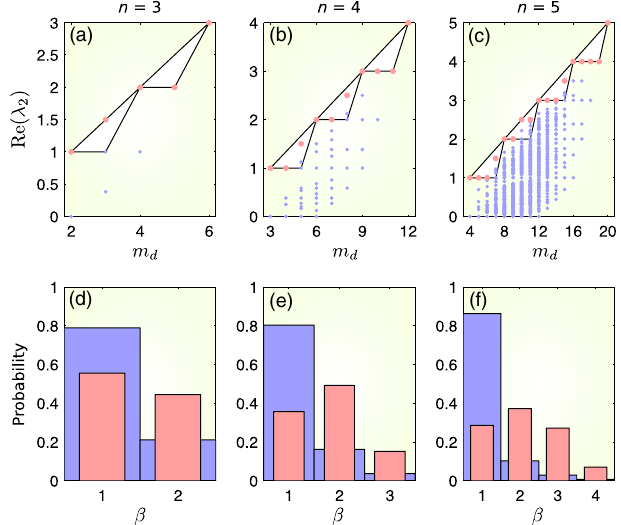
FIG. 5. Optimization induces spectral degeneracy. The maxi- mum Re ð λ 2 Þ is computed exactly through symbolic calculation of eigenvalues for all directed networks of size n ¼ 3 , 4, and 5. (a) – (c) Maximum values of Re ð λ 2 Þ as a function of the number of directed links, m d (red dots). All the other possible values of Re ð λ 2 Þ are indicated by blue dots. The black curves indicate the ¯ λ ¯ λ ⌋ upper bound and lower bound ⌊ for the maximum Re ð λ 2 Þ . The upper bound comes from Eq. (18), while the lower bound is derived in Sec. III B 3. (d) – (f) Probability distribution of geo- metric degeneracy β for λ 2 of all networks of a given size (blue bars) and of the Re ð λ 2 Þ -maximizing networks (red bars). For each network size, the difference between the two distributions shows that the maximization tends to increase β